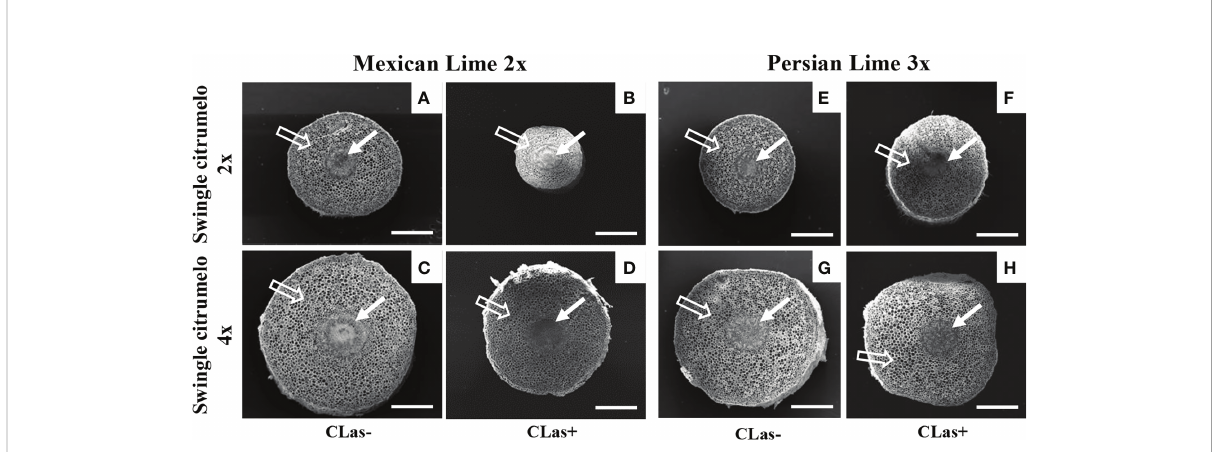
FIGURE 2 Transversal SEM pictures of 2x (A, B, E, F) and 4x (C, D, G, H) roots of Swingle citrumelo rootstocks grafted with 2x or 3x limes infected or not by CLas. Full white arrows show the central cylinder (phloem & xylem) of the root, and empty white arrows show the root cortex. Bars = 0.5 mm.